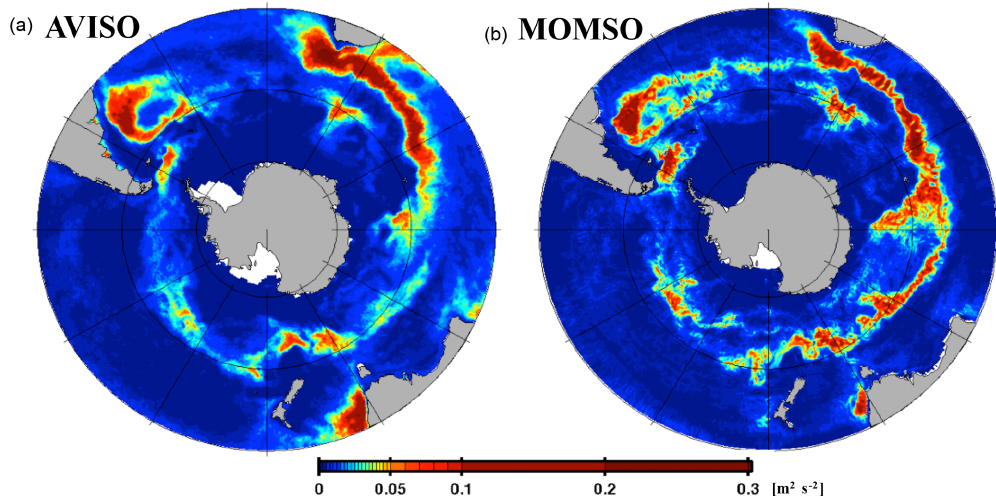
Figure 8. Eddy kinetic energy. Panel (a) is calculated from 1993–1998 satellite altimetry (Maps of Sea Level Anomalies and Geostrophic Velocity Anomalies (MSLA) Aviso data) observations. Panel (b) corresponds to a 6-year average (nominal years 1993 to 1998) calculated from daily averaged surface velocities from the reference simulation. The white patches in the left and right panels indicate missing data and (spurious) model land mask, respectively.